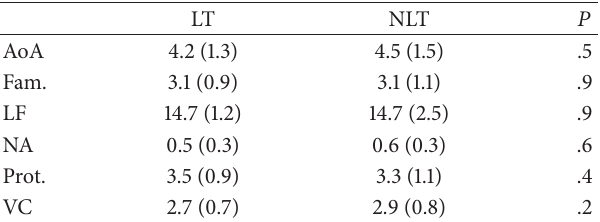
Table 2: Matching variables for LT and NLT stimuli (means and standard deviation, in